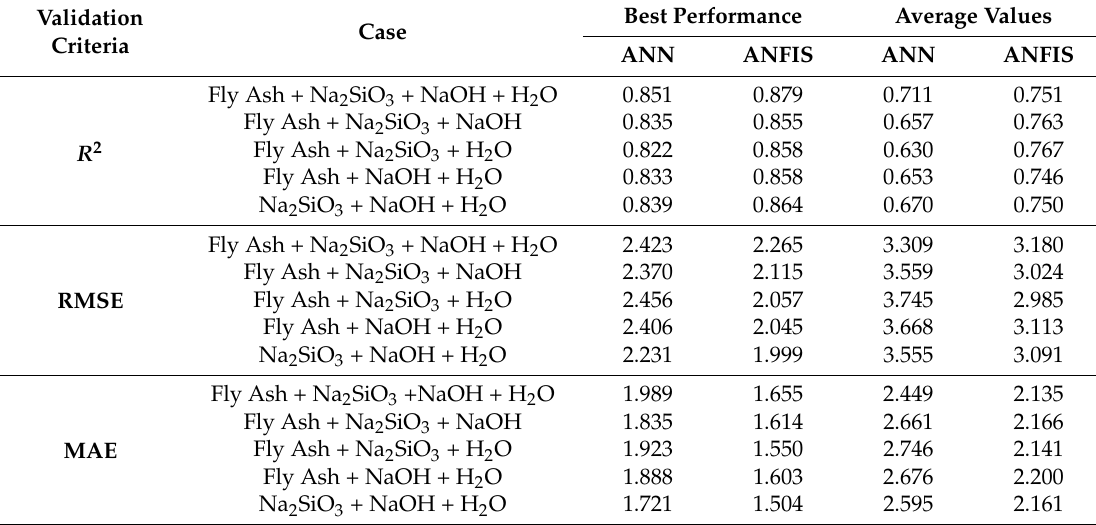
Table 2. Error values of ANN and ANFIS